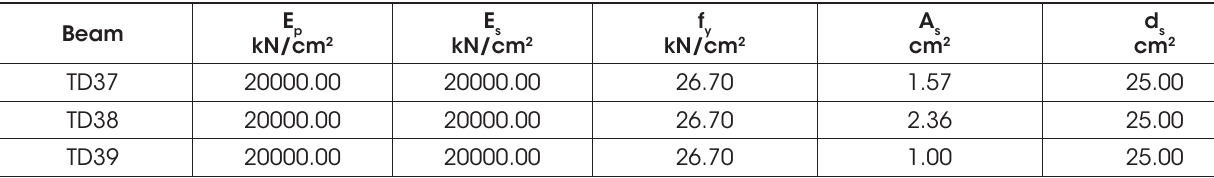
Additional data for the beams tested by TAO e DU [11]